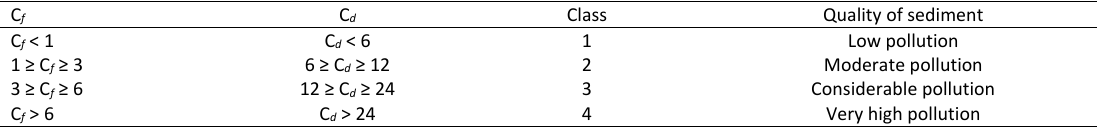
Table 3: Sediment quality according to contamination factor and contamination degree C f C d